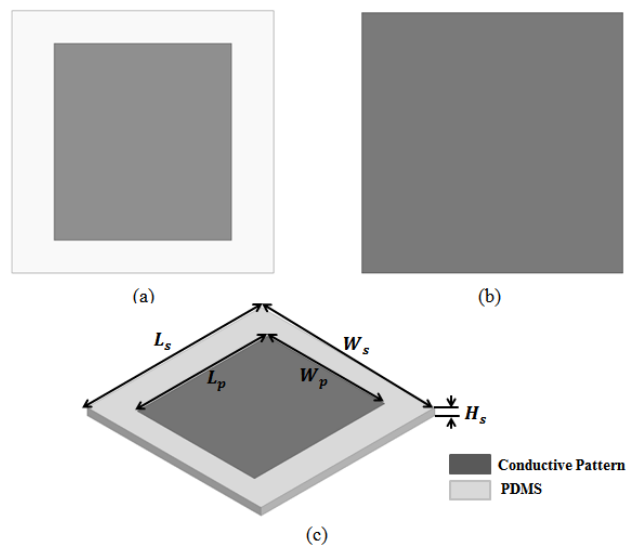
Figure 1. Unit cell geometry of the proposed electromagnetic absorber: ( a ) top view; ( b ) bottom view; ( c ) perspective view. L s = 12 mm; W s = 12 mm; L p = 8 mm; W p = 7 mm; H s = 0.5 mm. Conductive patterns are shown in dark gray.